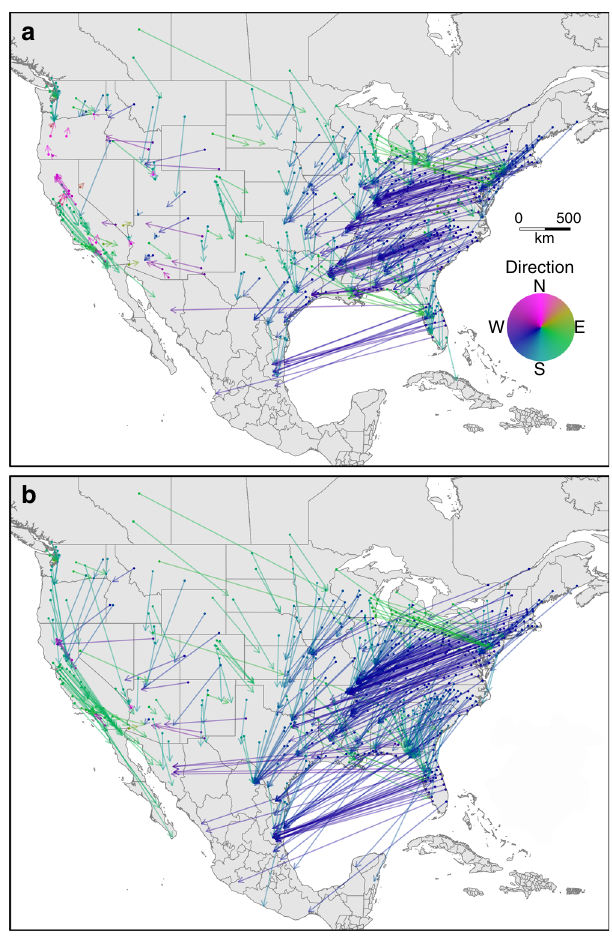
Fig. 2 Distance and direction to the best climatic analog. Arrows point from each urban area ( fi lled circles) to the location of the best contemporary climatic analog for that urban area ’ s climate in the 2080s based on the ensemble mean of 27 projections for a RCP4.5 and b RCP8.5. Shading indicates the initial bearing from each urban area to its best contemporary climatic